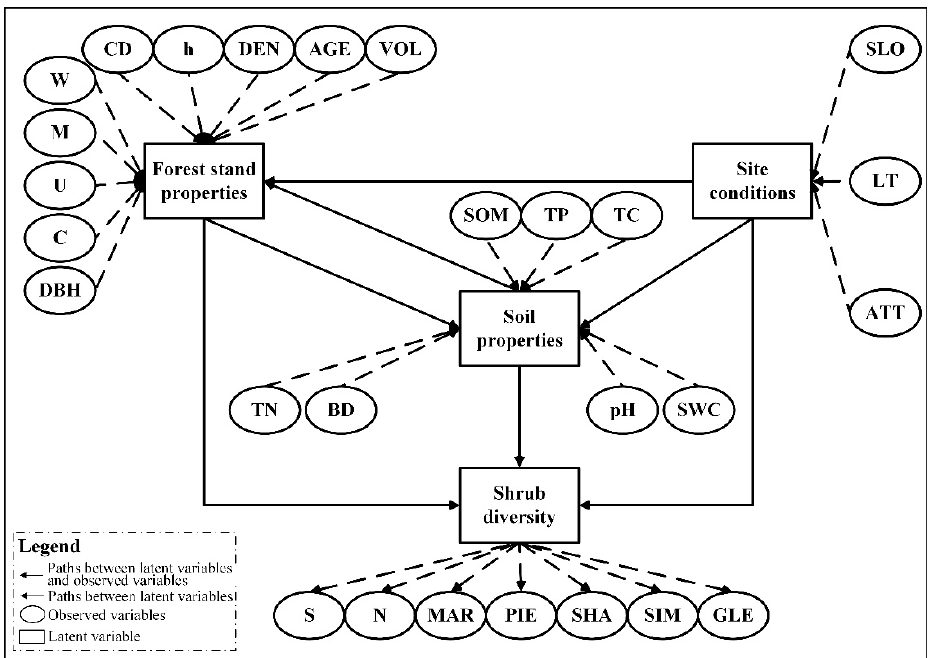
Figure 2. Preliminary partial least squares structural equation model which shows the relationship between latent variables. The arrow indicates the effect between latent variables or weight of observed variables to latent variables. The rectangles indicate the latent variables; the ovals indicate the observed variables. ATT, altitude; LT, litter thickness; SLO, slope; SOM, soil organic matter; TP, total phosphorus content; TC, total carbon content; SWC, soil water content; pH, power of hydrogen; TN, total nitrogen content; BD, bulk density; DBH, diameter at breast height; C, Crowding index; U, Dominance index; M, Mingling index; W, Uniform angle index; CD, canopy density; h, tree height; DEN, stand density; AGE, average age of the tree; VOL, forest stock volume; S, total shrub species, N, total number of individual shrub; MAR, Margalef index, PIE, Pielon index, SHA, Shannon-wiener index; SIM, Simpson index; GLE, Gleason index.